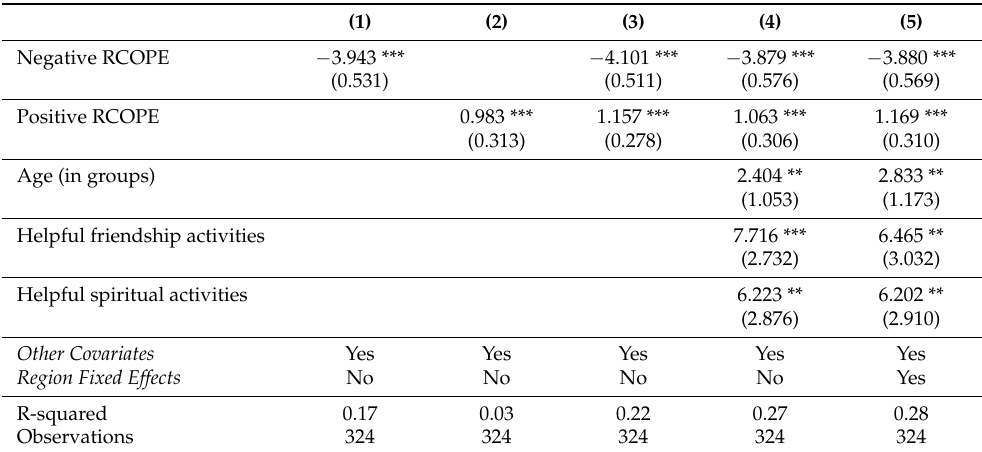
Table 3. Religious coping and psychological